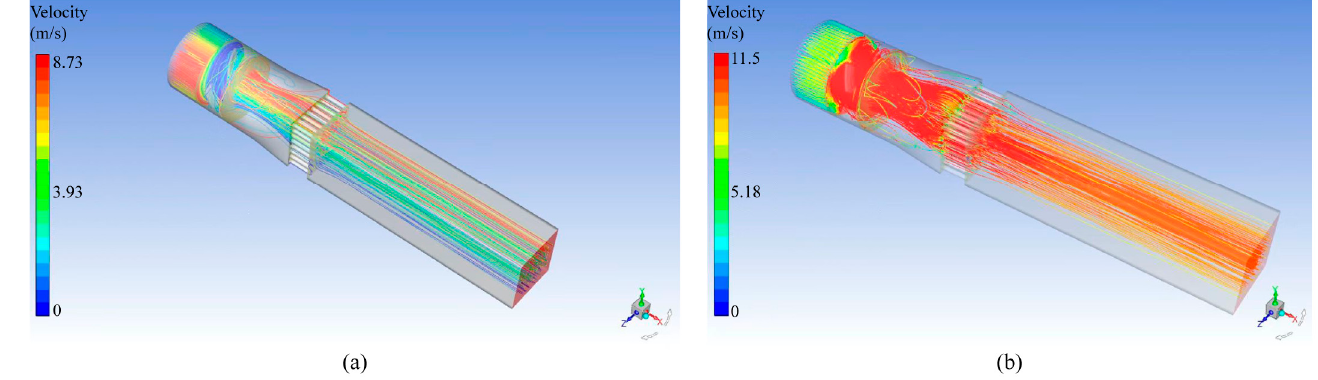
Figure 2. Distribution diagram of wind velocity inside the device. ( a ) Wind velocity distribution with type A; ( b ) Wind velocity distribution with type B.